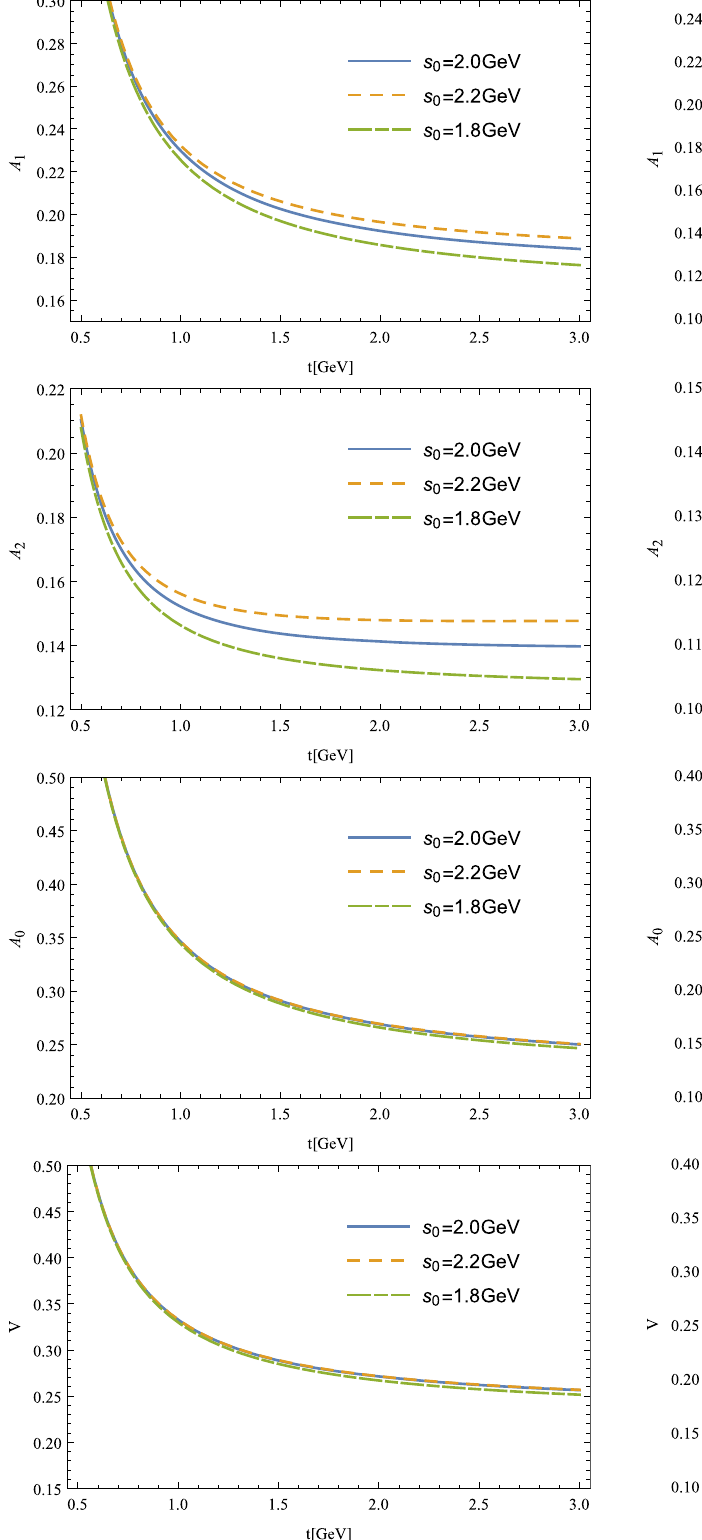
Fig. 2 B → f 2 ( 1270 ) form factors as functions of t for different s 0 at q 2 =